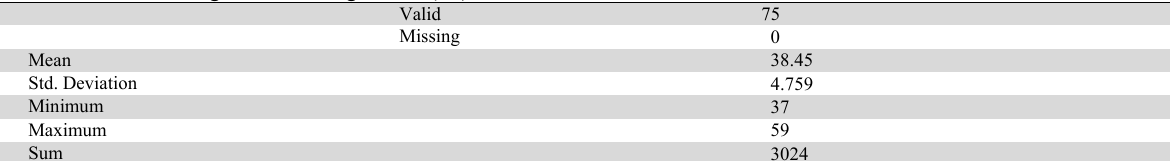
Statistical variables of government regulation (X 1 )